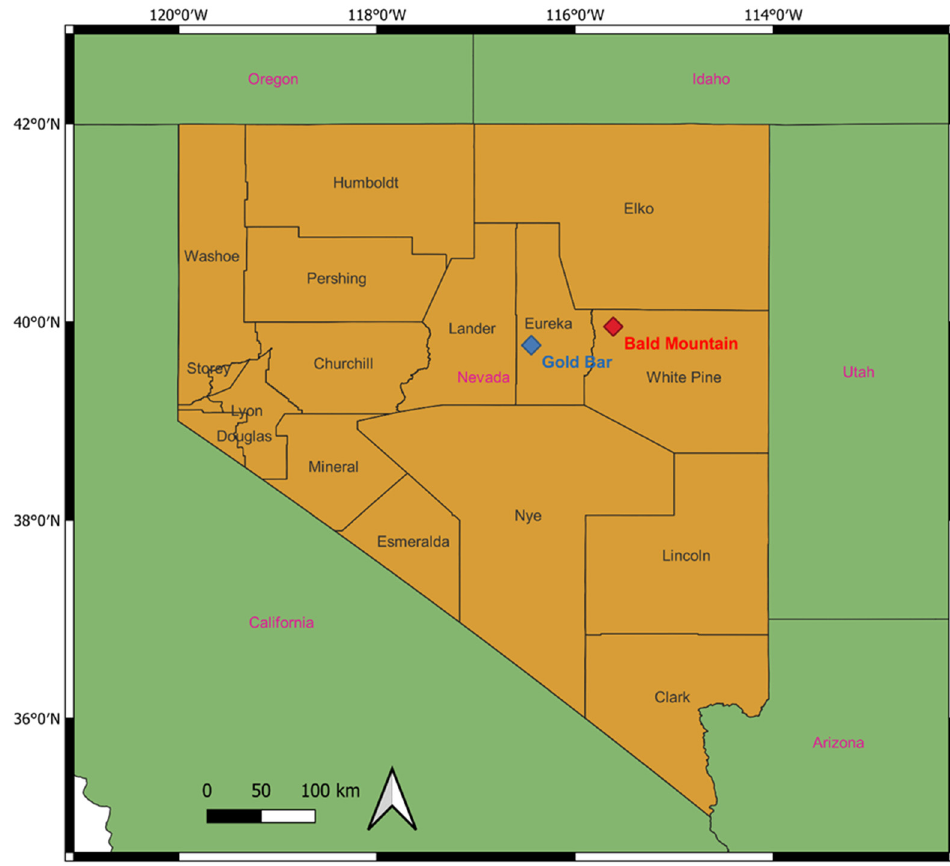
Figure 1. Location of Kinross Gold’s Bald Mountain mine (39°56’N, 115°36’W, WGS 84) and McEwen Mining’s Gold Bar mine (39°47’N, 116°20’W, WGS 84) shown by the red and blue diamond symbols, respectively.